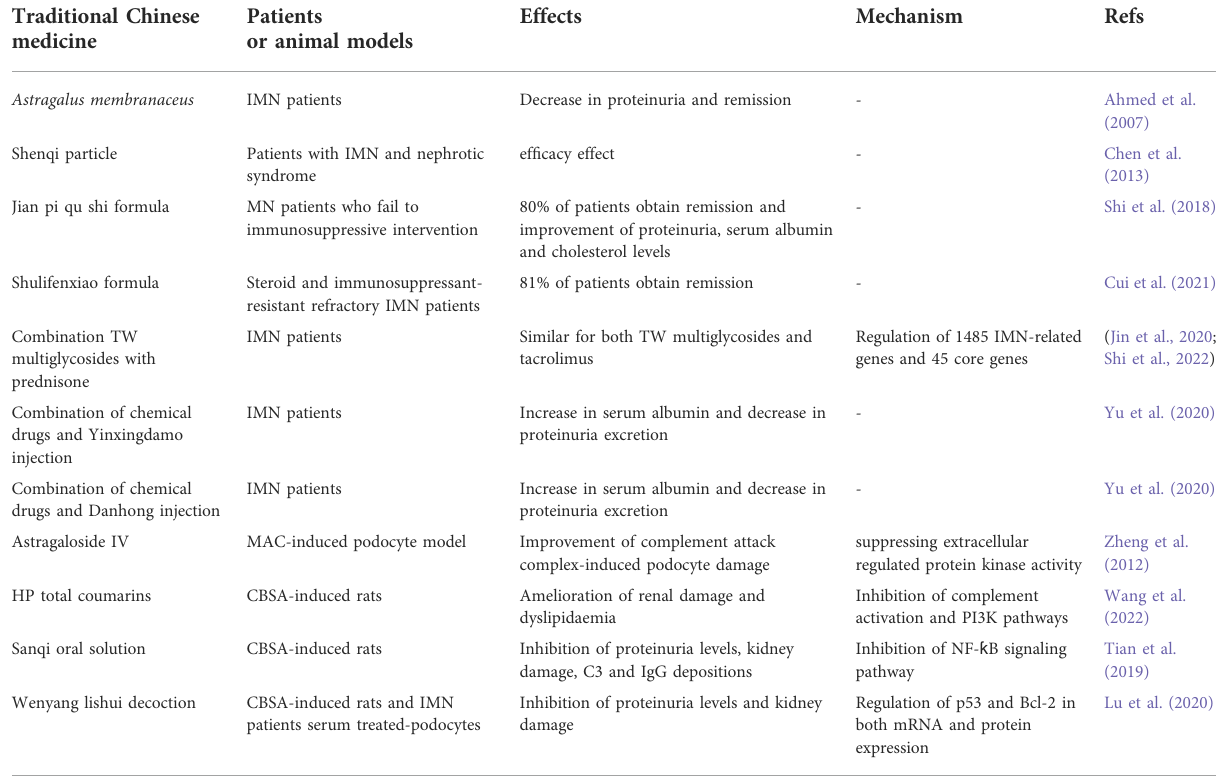
TABLE 1 Treatment of traditional Chinese medicine on patients and animal models with